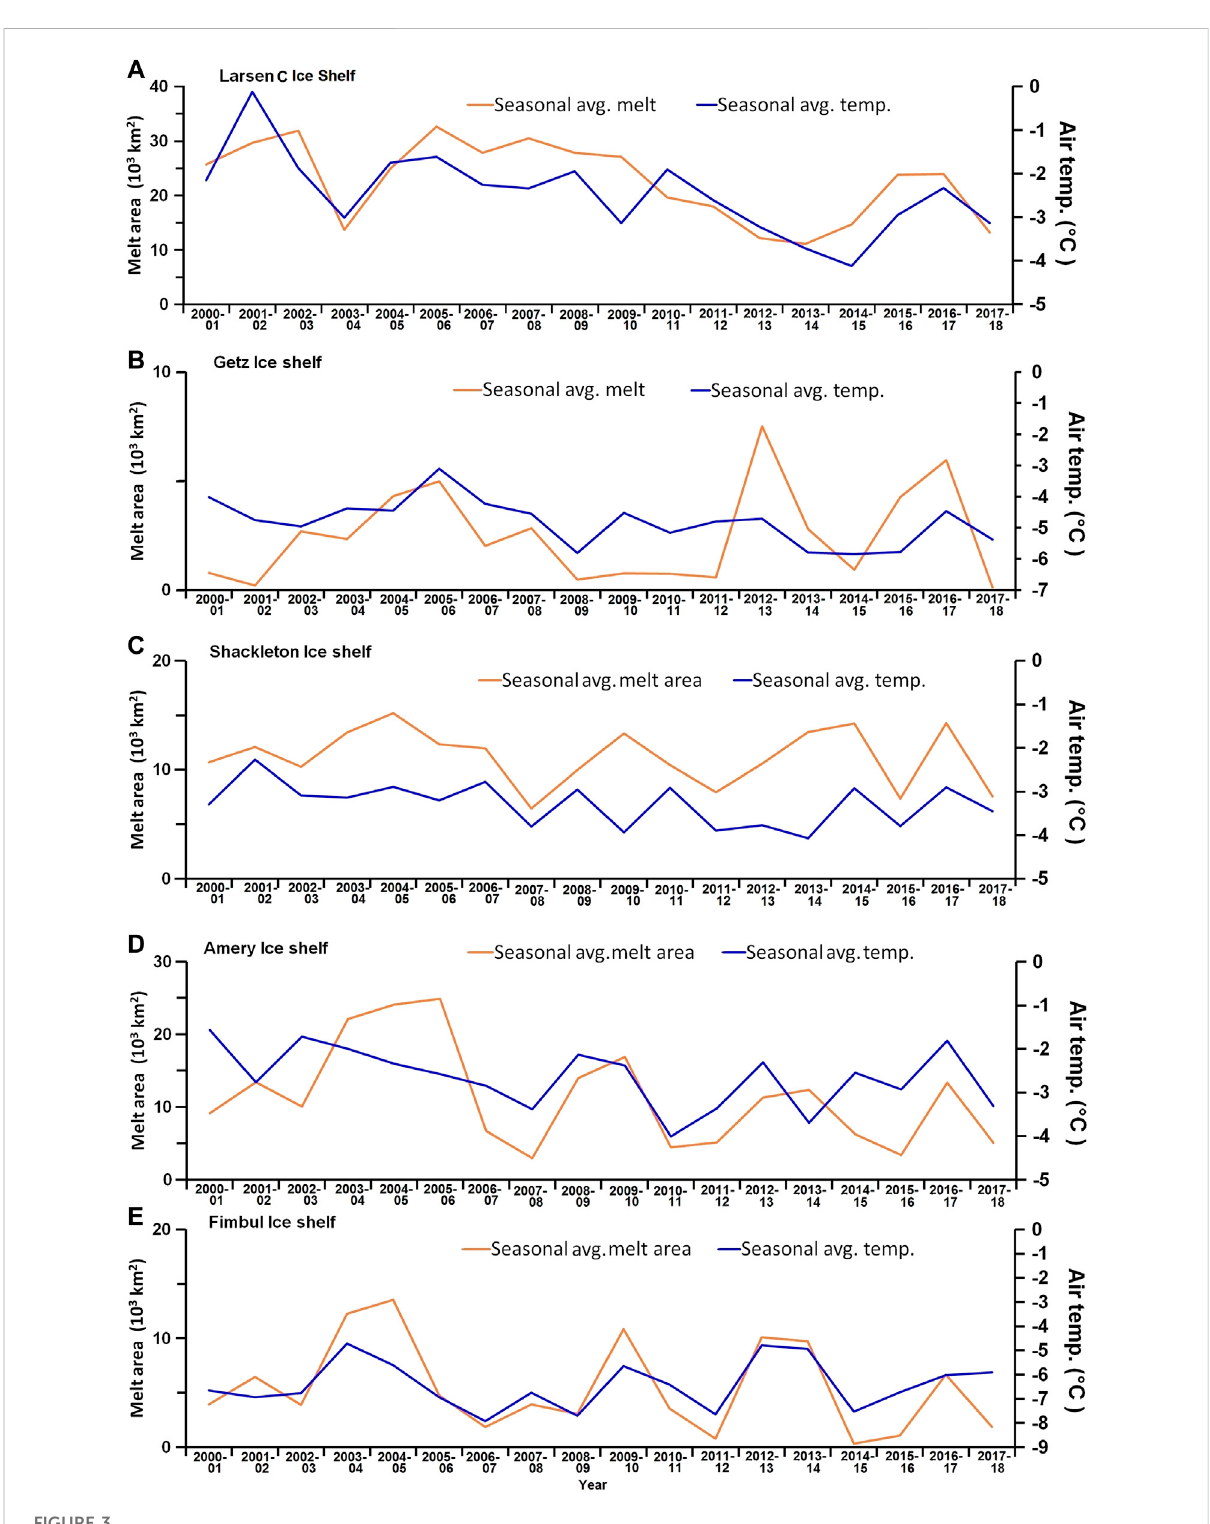
FIGURE 3 Relationshipbetweensnowmelt-areaandairtemperatureduringaustralsummerfor (A) LarsenCiceshelf, (B) Getziceshelf, (C) Shackletonice shelf, (D) Amery ice shelf, and (E) Fimbul ice